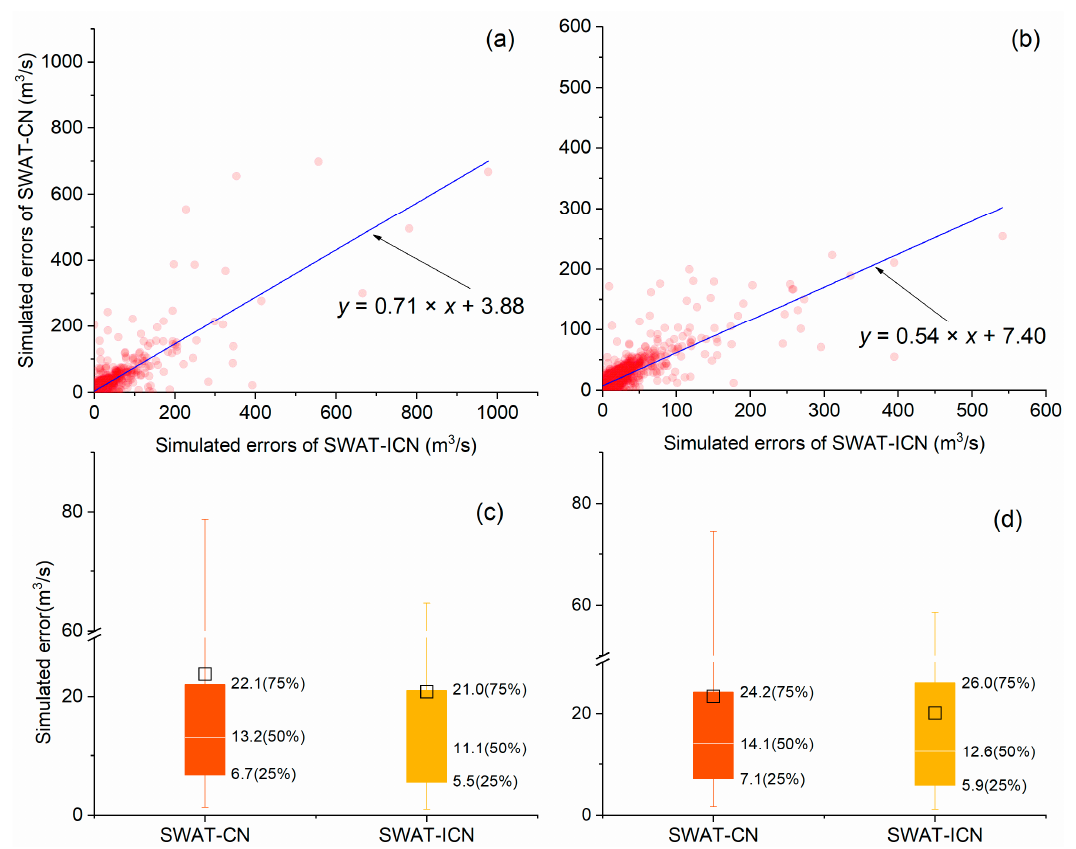
Figure 6. Simulated errors of SWAT-ICN versus SWAT-CN for calibration ( a ) and validation ( b ) periods, and statistics on the simulated error for calibration ( c ) and validation ( d ) periods.